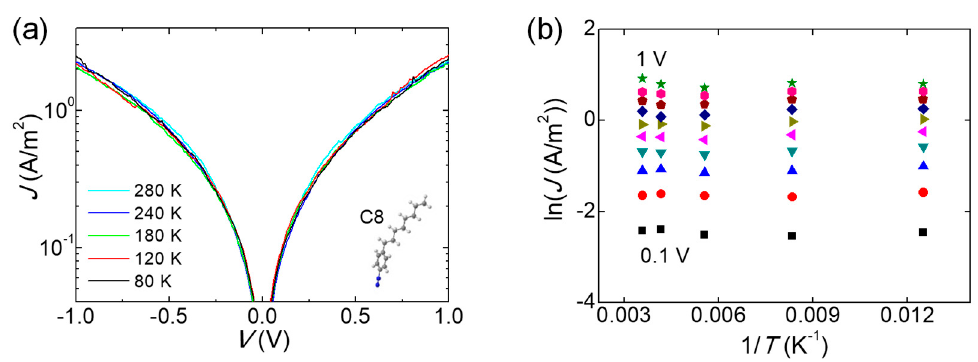
Figure 4. ( a ) Representative J − V curves of the C8 junction on a semi-log scale as the temperature varies from 80 to 280 K. ( b ) Arrhenius plots of the current density at different voltages from 0.1 to 1 V.